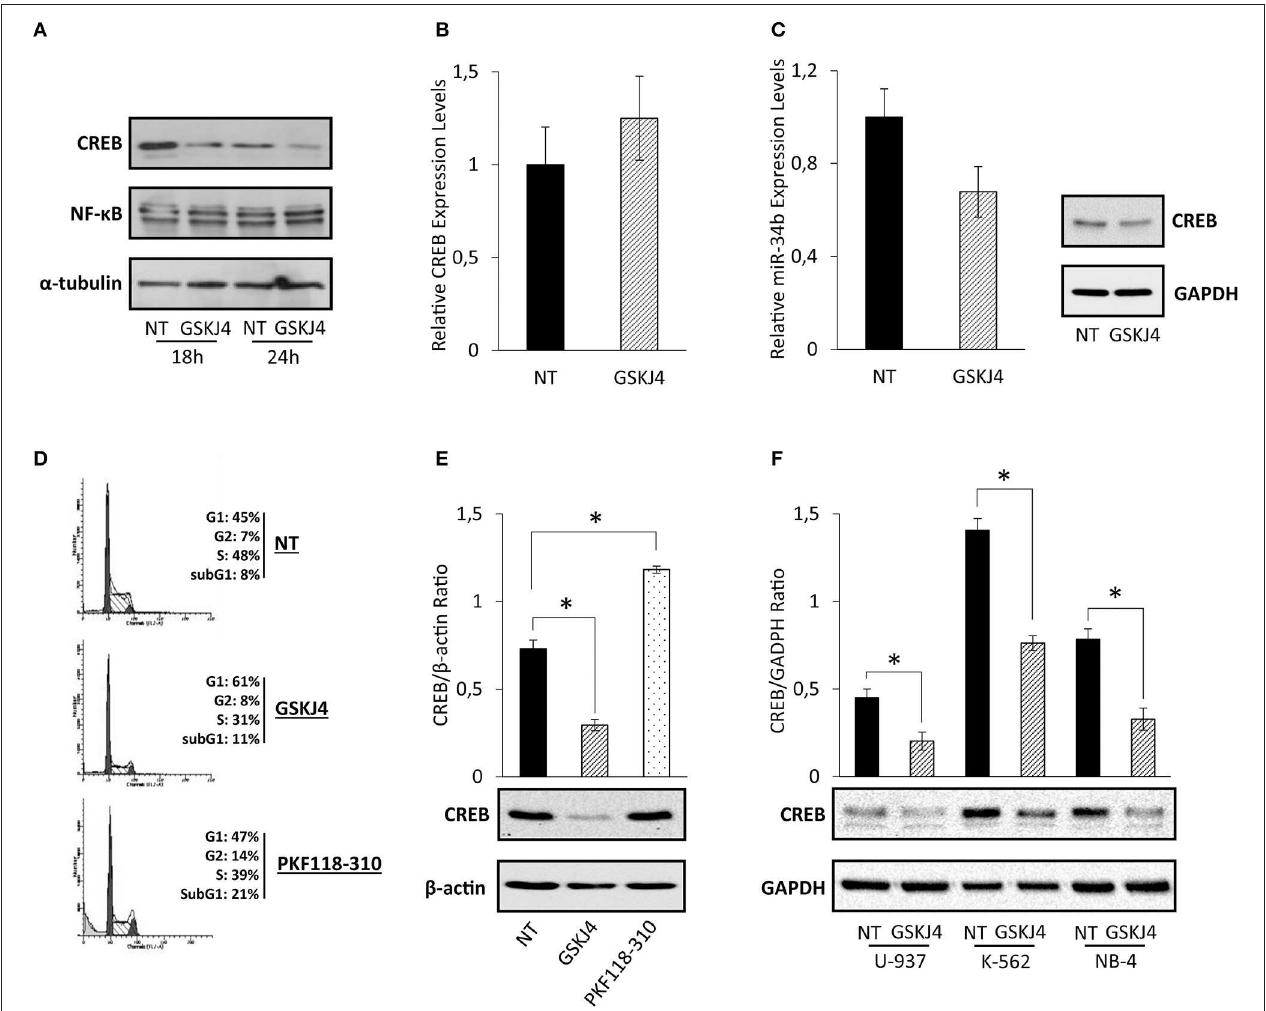
FIGURE 2 | GSKJ4-mediated effects on cAMP response element-binding (CREB) protein, CREB mRNA, and miR-34b: reliability and specificity perspectives. (A) CREB and NF- κ B protein levels were defined by immunoblotting after 18 and 24h of treatment with 10 µ M GSKJ4. CREB (B) and miR-34b (C) mRNA expression levels were assessed by RT-PCR after 24h of 10 µ M GSKJ4 treatment. GAPDH was used as a housekeeping gene, whereas differences were calculated by 11 Ct method. (D) Representative cell cycle analysis of propidium iodide (PI)-stained cells achieved after 24h of 10 µ M GSKJ4 and 0.25 µ M PKF118-310 treatment were reported. (E) CREB protein levels and CREB/ β -actin Ratio, obtained in response to the same experimental setting illustrated in (D) , were also displayed. (F) U-937, K-562, and NB-4 cells were kept under GSKJ4 treatment for 24h. Later, CREB protein levels were analyzed by Western blotting. Data from three biological replicates were used to calculate average and SD values shown in the densitometric histogram plot. * P < 0.05 by ANOVA and unpaired t